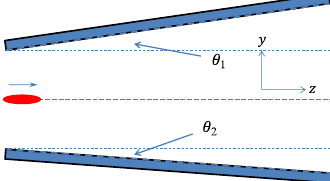
FIG. 19. Emittance increase versus the rotation angle θ 1 ( θ 2 ¼ 0 ) for a